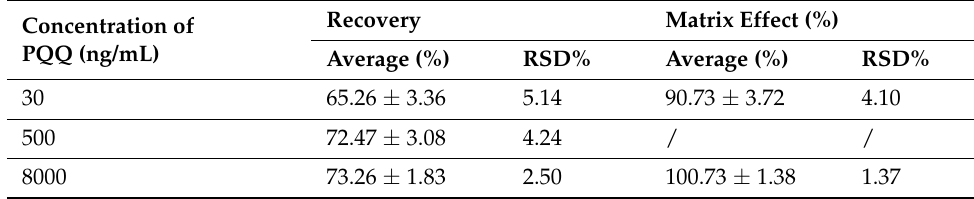
Table 3. Recovery and Matrix effect of the method.